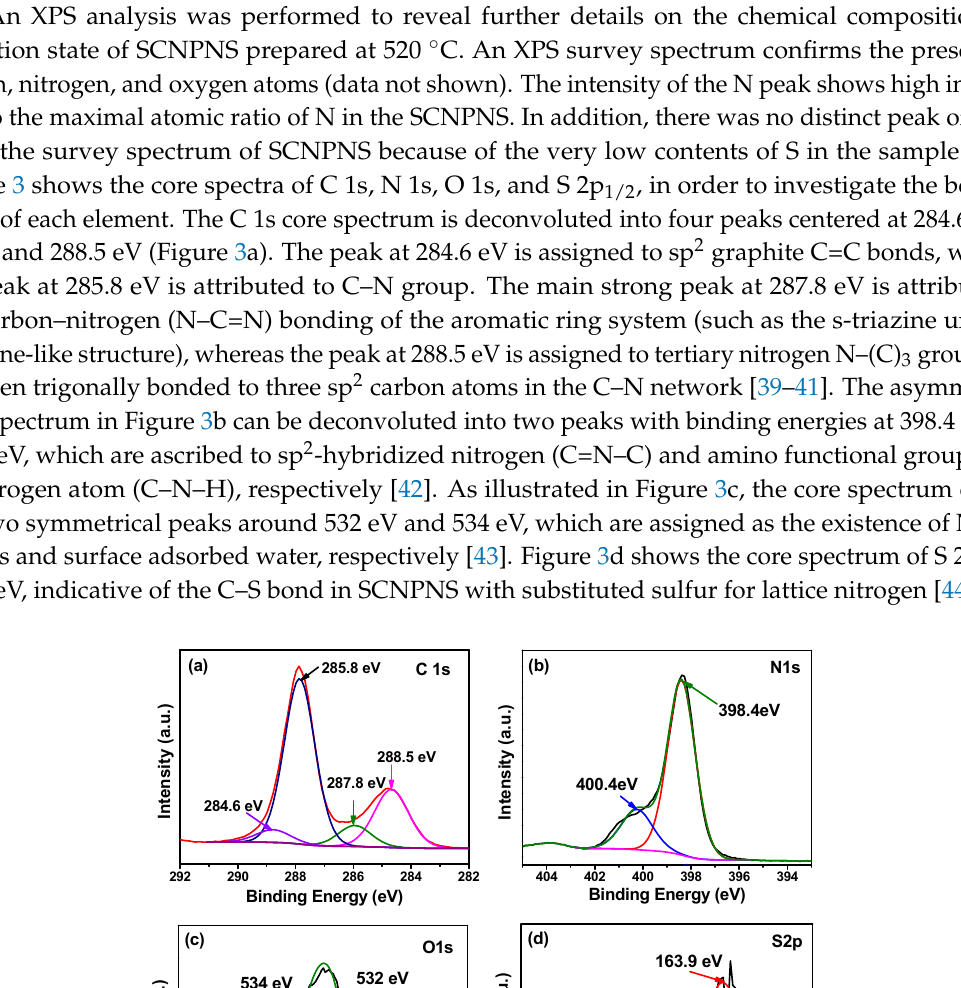
Figure 2. ( a ) Nitrogen adsorption – desorption isotherm of SCNPNS and ( b ) the corresponding pore size distribution.